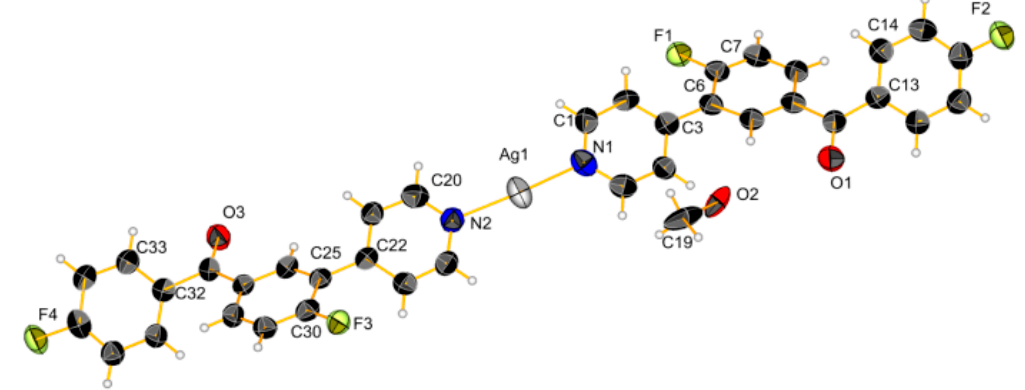
Figure 6. View of the complex 4b in ellipsoid 50% probability.